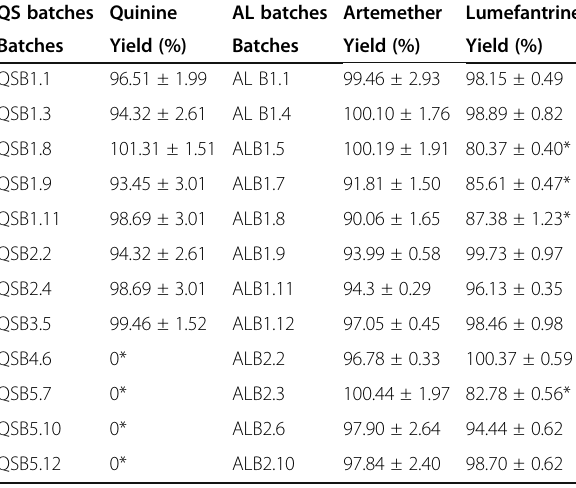
Table 2 Results of quantitative assays QS batches Quinine